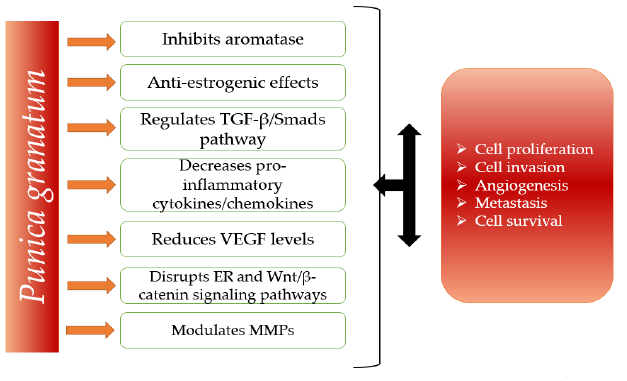
Figure 1. Anti-cancer mechanisms of Punica granatum and molecular targets.